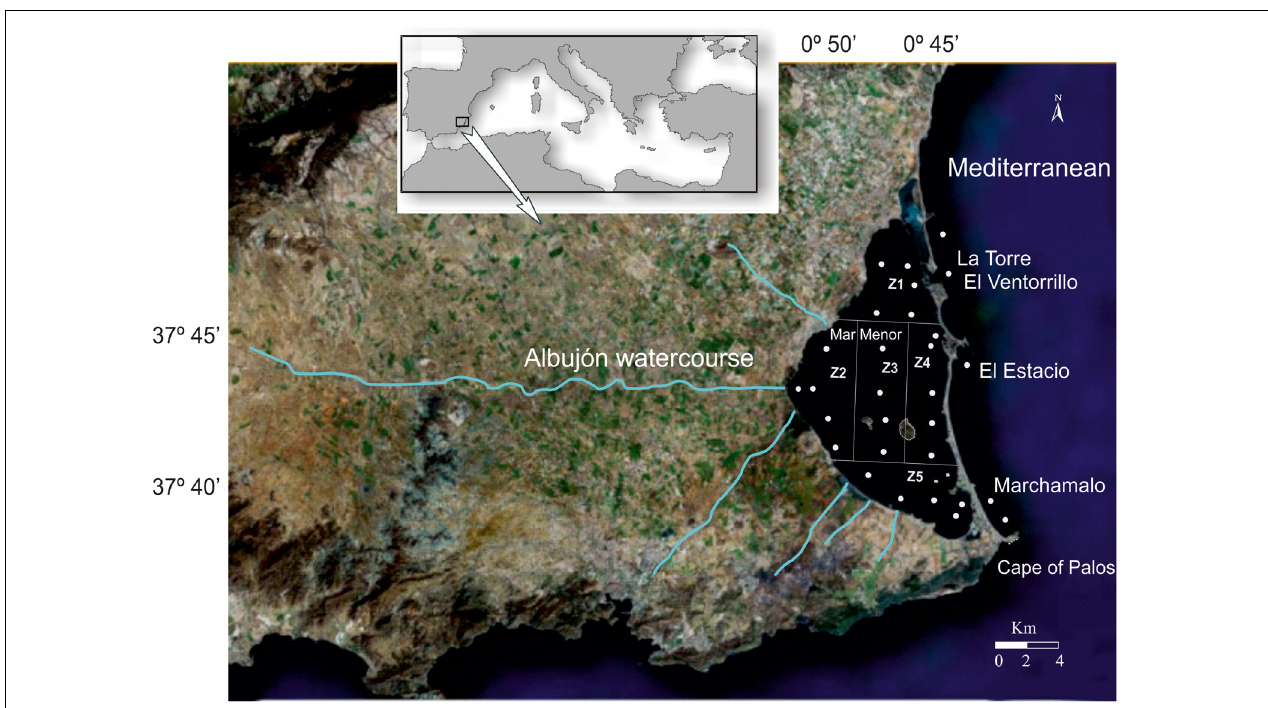
FIGURE 1 | Location of the Mar Menor, its drainage basin that is delimited by the mountain ranges that extend along the north, west, and south limits of the image, and the main watercourses that flow into the lagoon. Points represent the network of sampling stations used in the monitoring